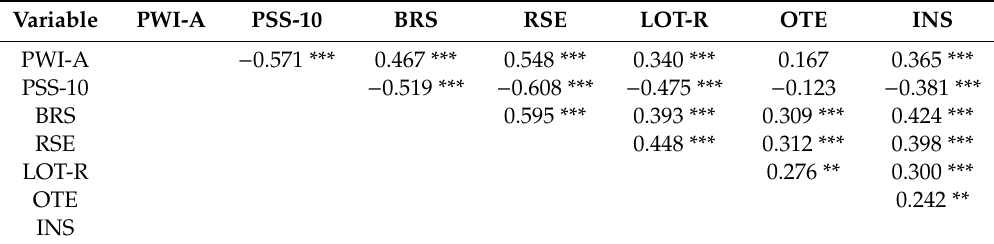
Table 4. Pearson’s Correlation Statistics for Study